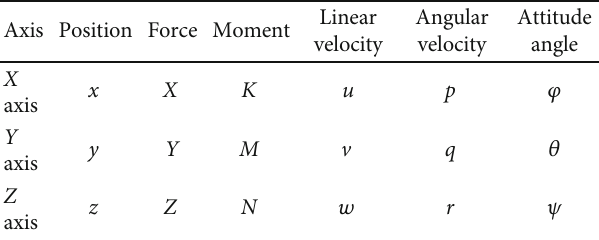
Figure 2: Frames and elementary lander motions. Table 2: De fi nition of dynamic parameters of a moveable